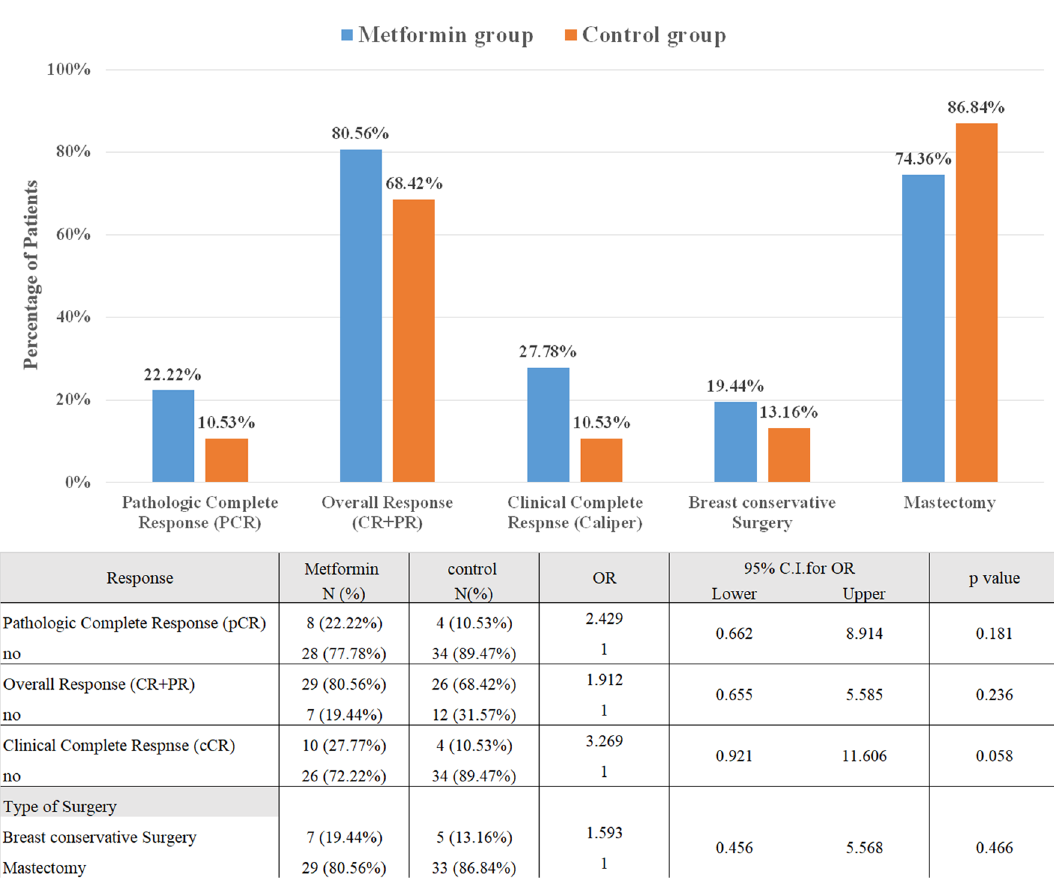
Figure 2. Effect of metformin on the different endpoints.